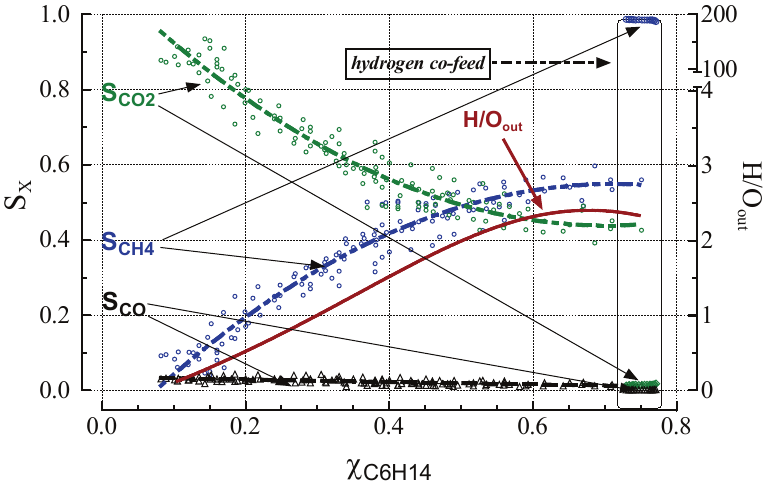
Figure 3. Overall conversion-selectivity (S (see Table 1) and reaction times (adapted from ref. [15] with the kind permission of Wiley, copyright